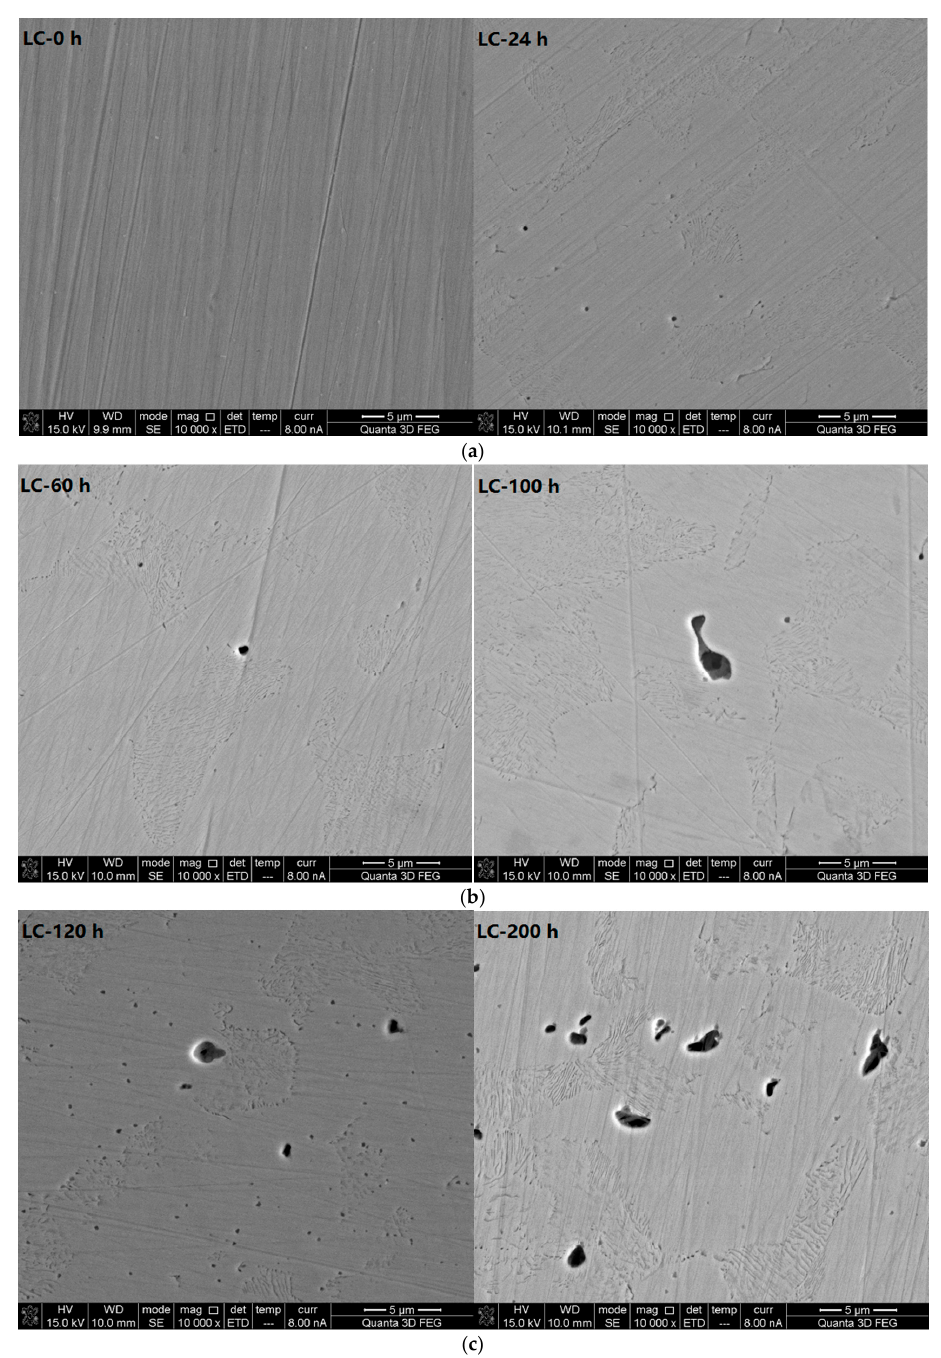
Figure 5. Scanning electron microscope photos (10,000× magnification) of carbon steel bars at different corrosive exposure times. ( a ) Micrograph of LC at 0 and 24 h; ( b ) Micrograph of LC at 60 and 100 h; and ( c ) Micrograph of LC at 120 and 200 h.